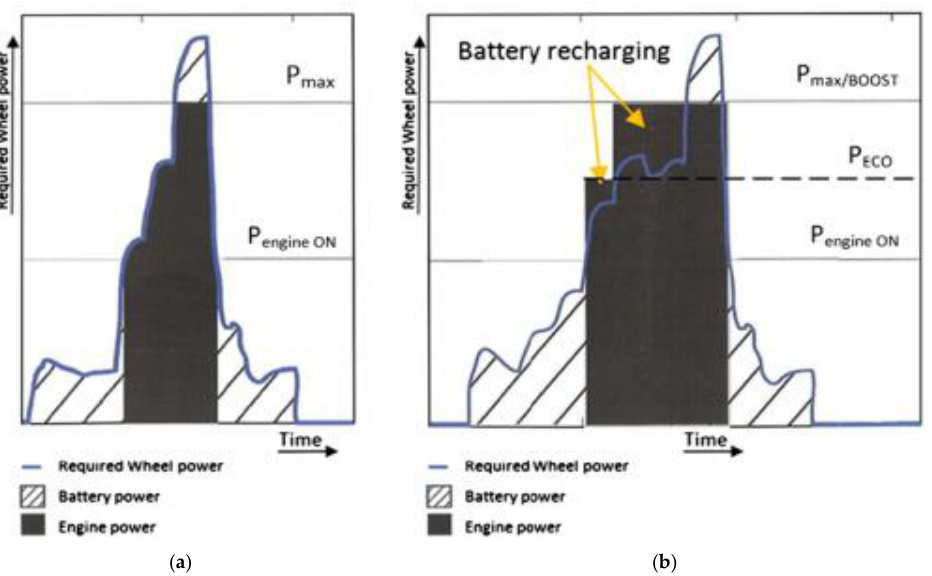
Figure 1. Comparison between electric vehicle (EV) charge sustaining strategies with range extenders (REs): ( a ) variable engine load mode following instantaneous electrical demand and ( b ) dual power set point engine mode (ECO/BOOST) used in the present work, adapted from [2].